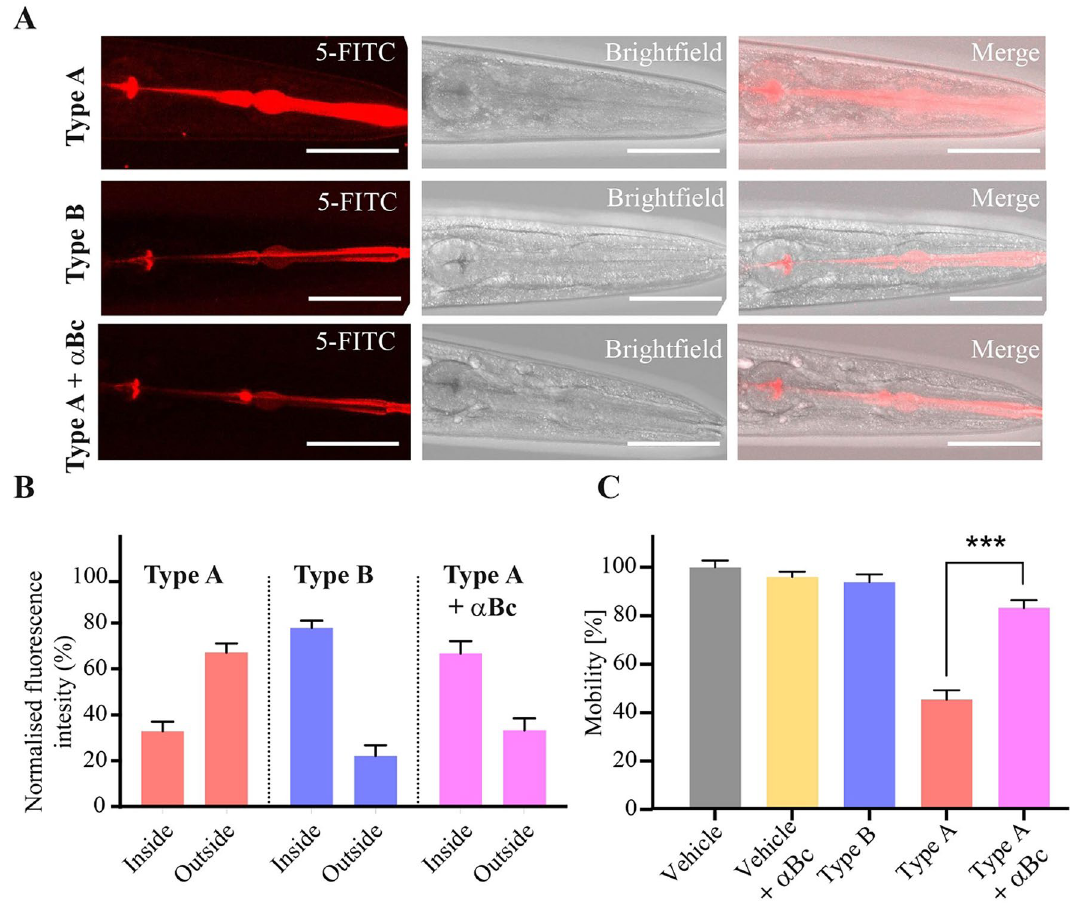
Figure 3. Oligomer uptake from the intestinal lumen to the internal tissues of the worms. ( A ) Representative images of oligomer localisation obtained by confocal microscopy. Horizontal bars in the images indicate 100 μm. ( B ) Quantification of uptake of the oligomers from the intestinal lumen (inside) to the internal tissues (outside) of the worms. Worms were exposed to 12 µM of type A, or type B oligomers or with type of A oligomers with αB-crystallin (αBc) at a 5:1 HypF-N:αB-crystallin molar ratio (Type A + αBc) at D0. HypF-N was labeled with 5-FITC or unlabeled. All oligomers were incubated with 300 wild-type worms over a period of 12 h, after which confocal microscopy images were acquired. Bars indicate mean and SEM values. ( C ) Analysis of the motility of worms exposed at day 0 (D0) to 48 µM type B (blue), type A (red), type A oligomers with 9.6 μM αB-crystallin (pink) or left unexposed (“vehicle”, grey) and treated with αB-crystallin only (“vehicle + αBc”, yellow) and analyzed after 6 h of incubation. Bars indicate mean and SEM values. One representative of three experiments, all of which showed similar results, is shown. Statistical tests (Student’s t test) were carried out using Graph-pad prism. The triple (***) asterisks indicate P ≤ 0.001, relative to worms exposed to type A